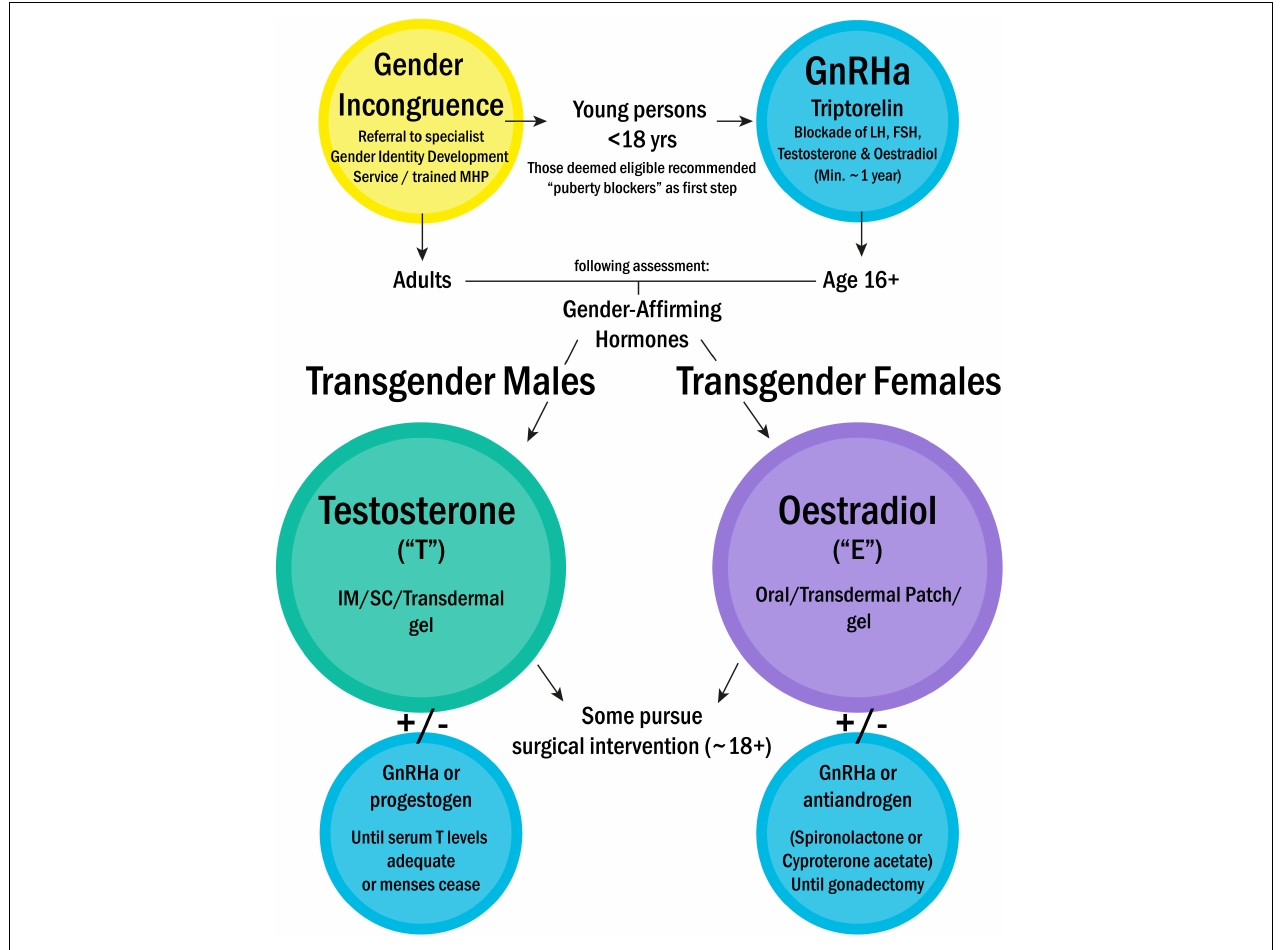
FIGURE 1 | Treatment pathway for gender incongruence, as recommended by the Endocrine Society (42). Treatment is prescribed on a case-by-case basis, based on individual country guidelines. This flowchart outlines the most commonly pursued routes. NB- Parenteral oestradiol not currently used in Europe. MHP, Mental health professional; GnRHa, Gonadotropin releasing hormone analogs; LH, Luteinising hormone; FSH, Follicle stimulating hormone; IM, Intramuscular; SC,